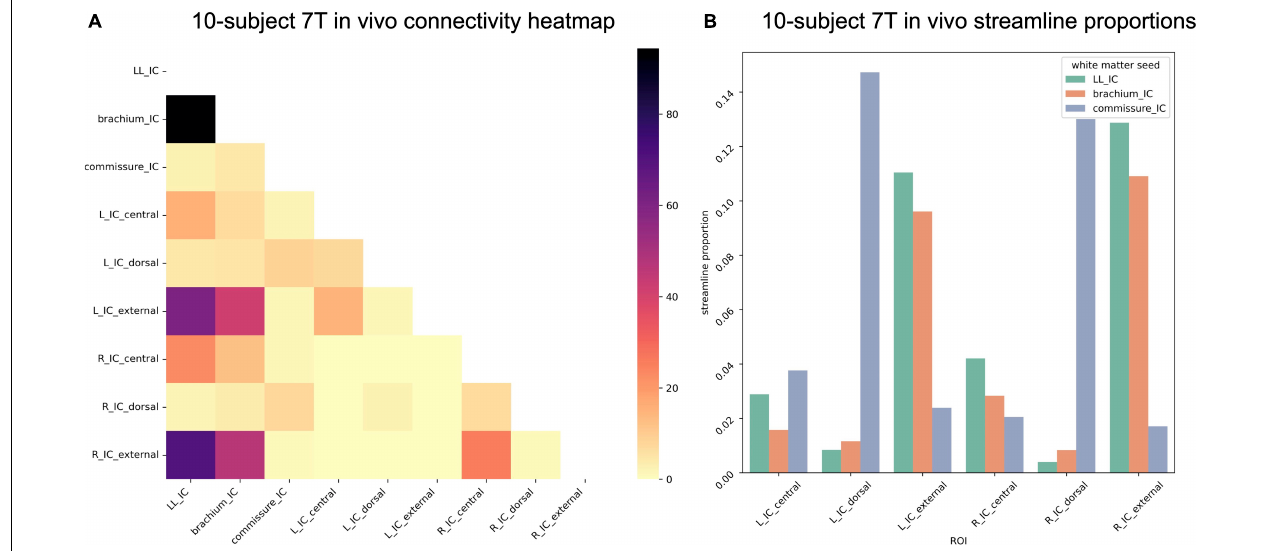
FIGURE 10 | (A) Connectivity matrix of 7T in vivo inferior colliculus (IC) subdivisions and adjacent white matter tracts (values indicate number of streamlines averaged across 10 participants); (B) proportion of streamlines reaching each white matter region for each IC